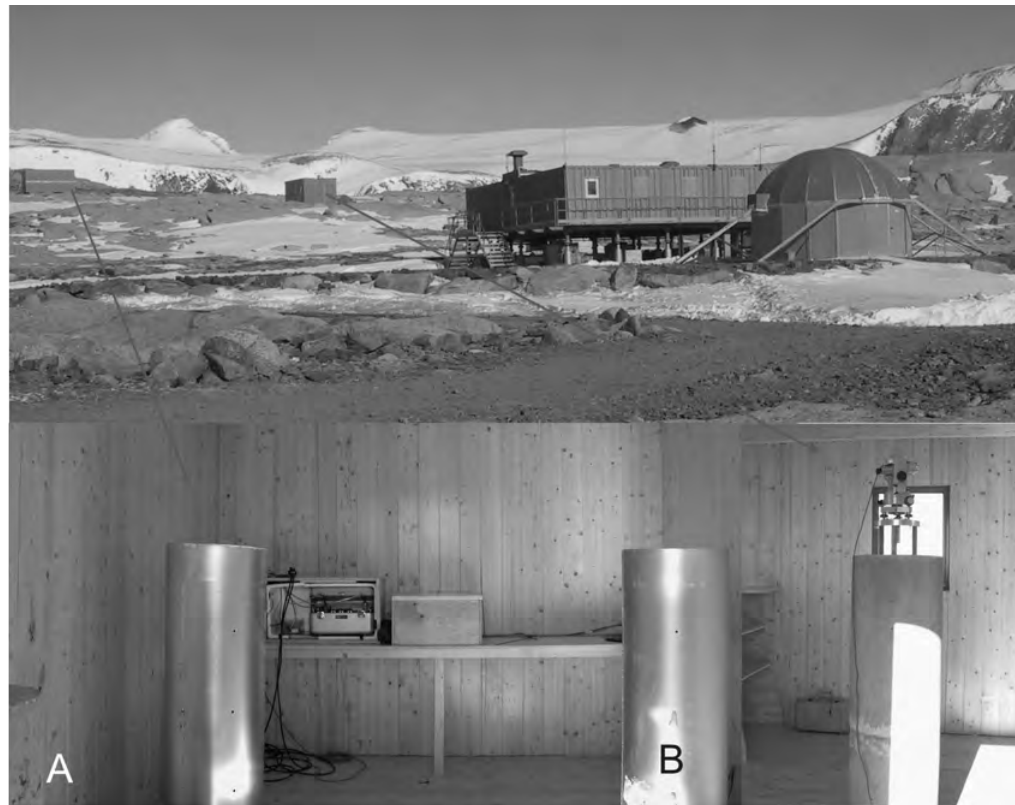
Fig. 1a,b. Geomagnetic observatory at Mario Zucchelli Station: a) variometer shelter; b) absolute measure- ment